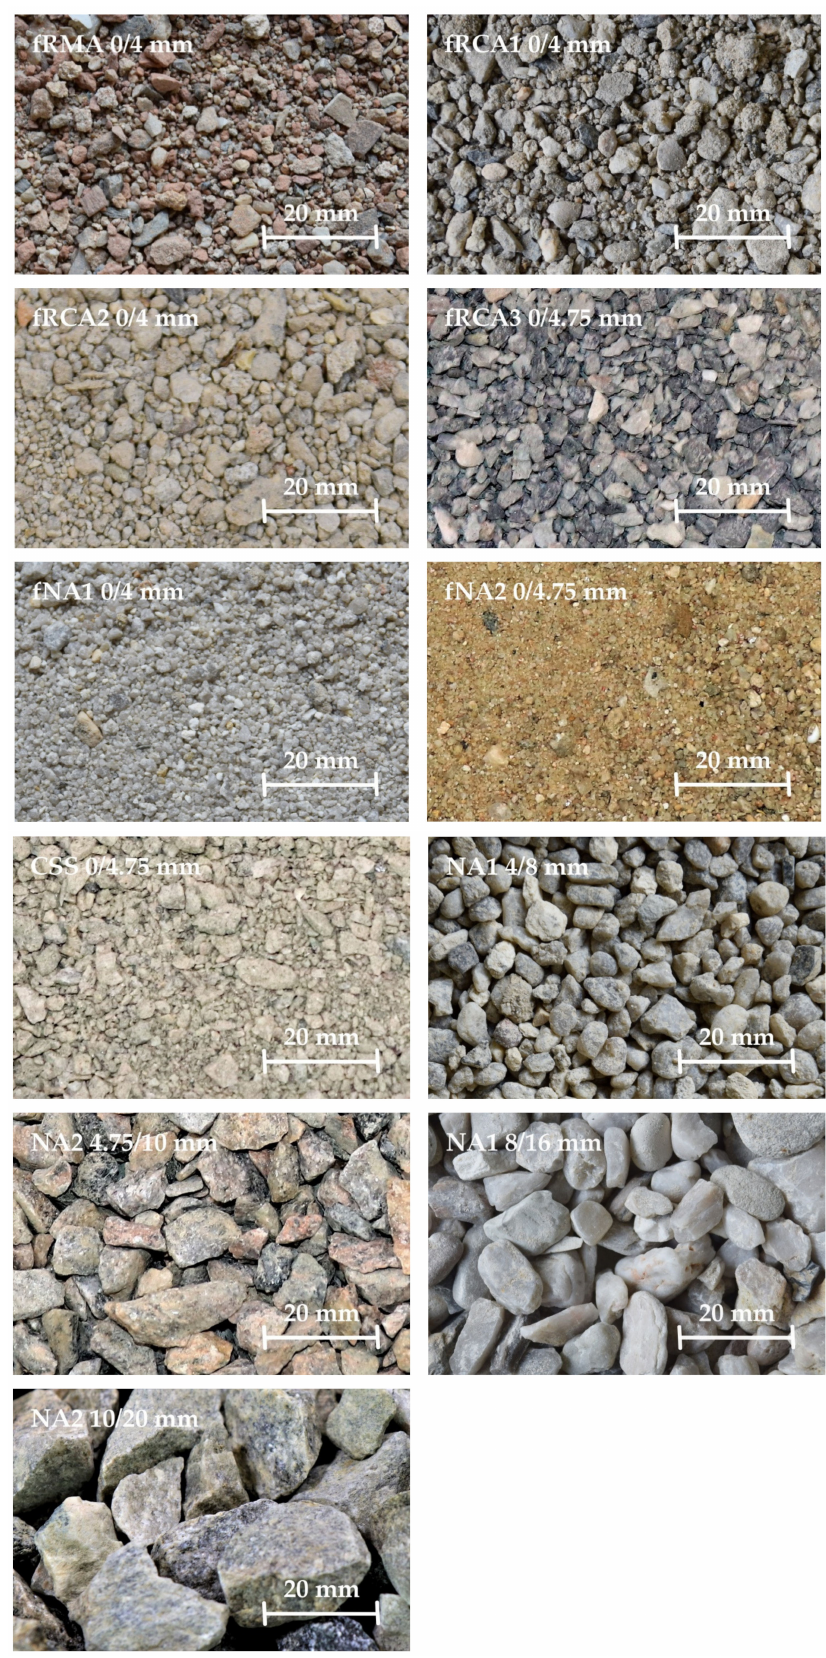
Figure 1. NA and RA used in concrete